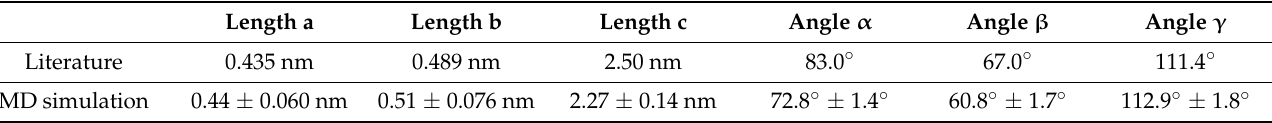
Table 2. Unit cell parameter of the C18 lattice taken from [23] and computed by MD